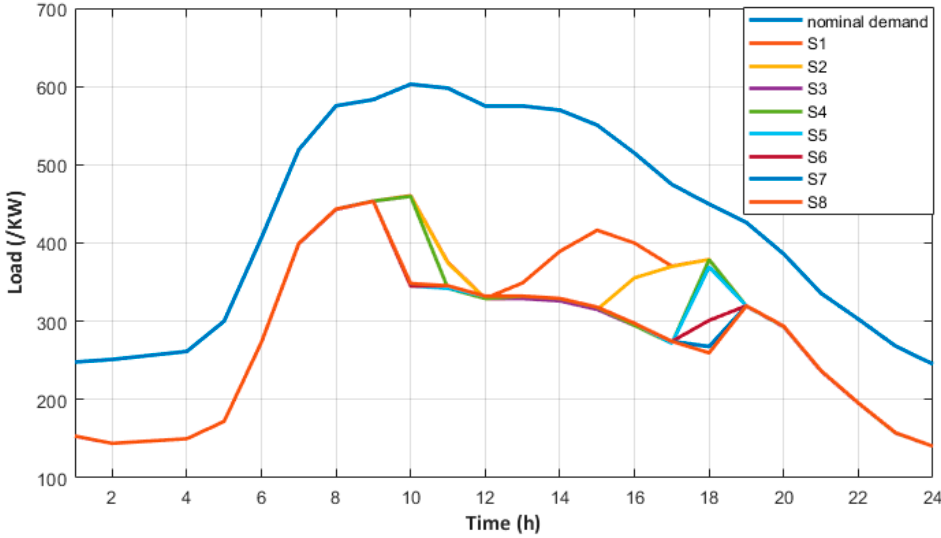
Figure 11. Nominal demand and demand per scenario for 9 October 2019. (source: Authors). Table 9. Income, profit, and profitability for the various elasticity values.